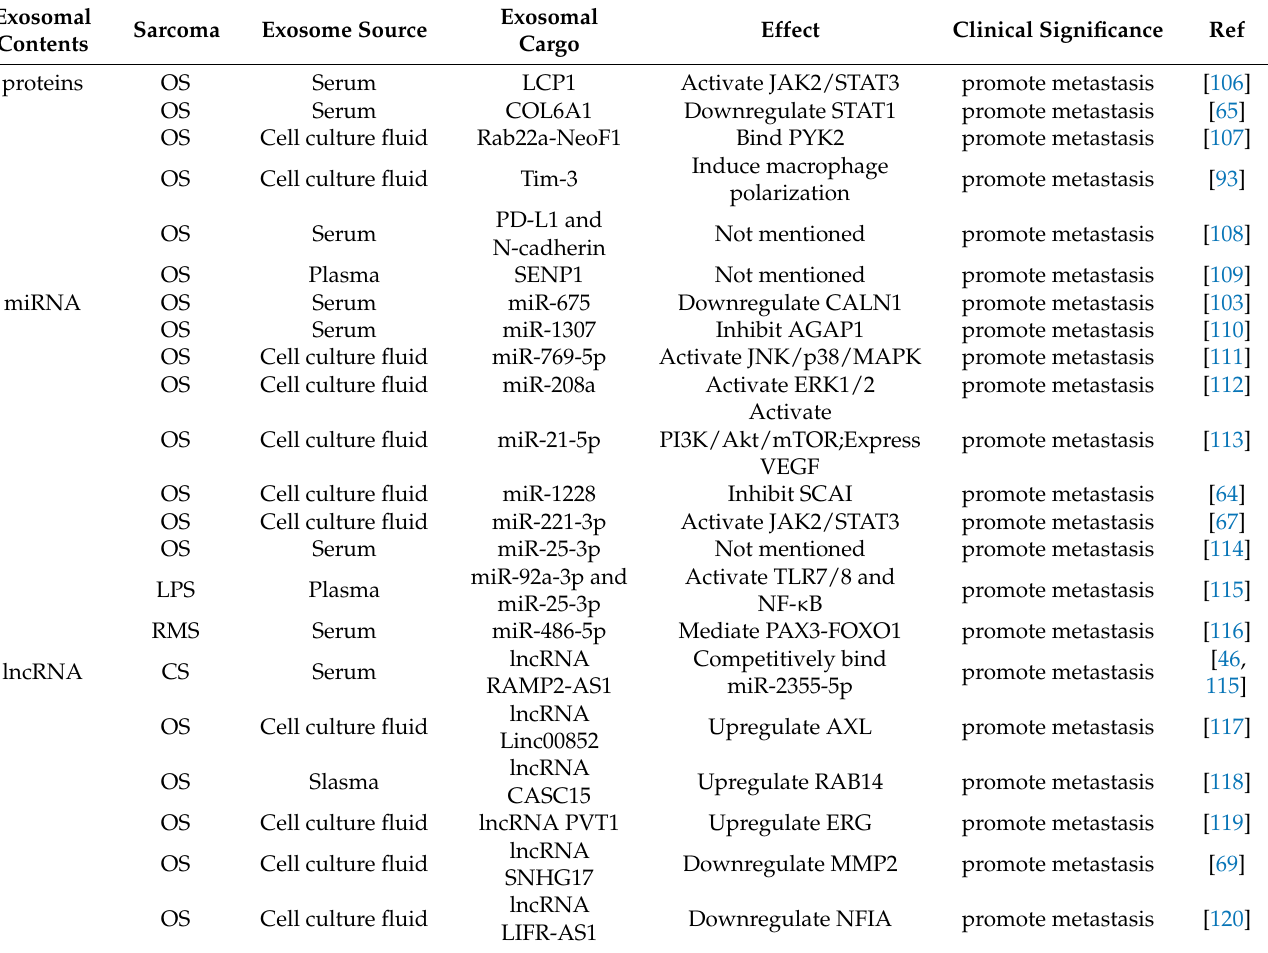
Table 1. Exosomal markers in sarcoma